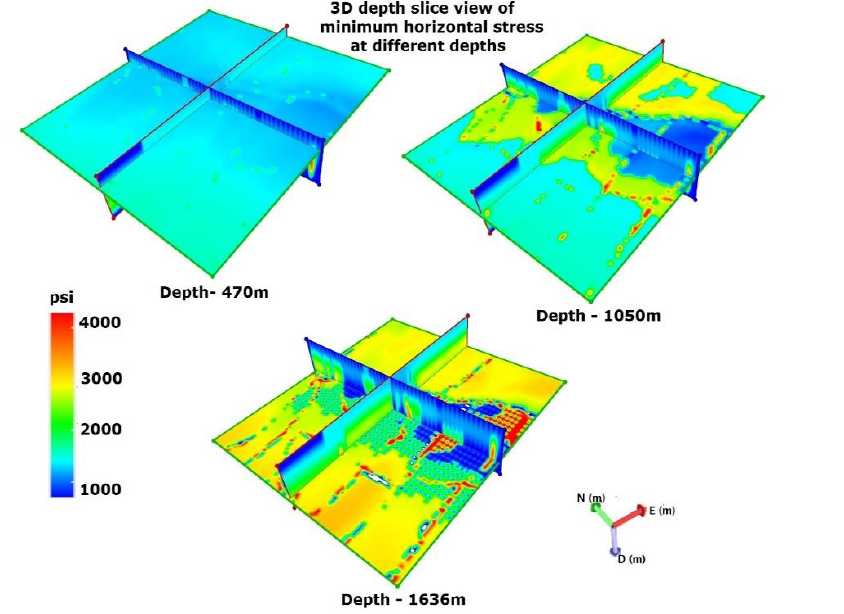
Figure 11. 3D view of minimum horizontal stress variation in the spatial directions at 400m, 1050m, and